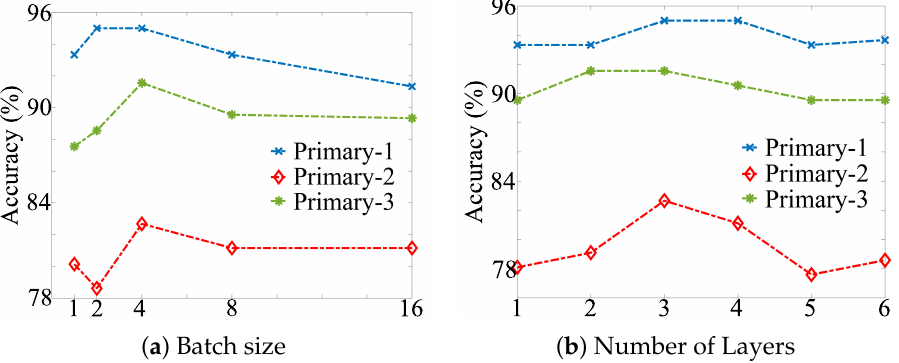
Figure 2. Influence of the number of layers ( a ), and of the batch size ( b ) on the classification accuracy of HBcompare. Accuracy is shown on all three primary datasets (blue, red and green lines), and was highest for batch size 4 and for 3 GCN